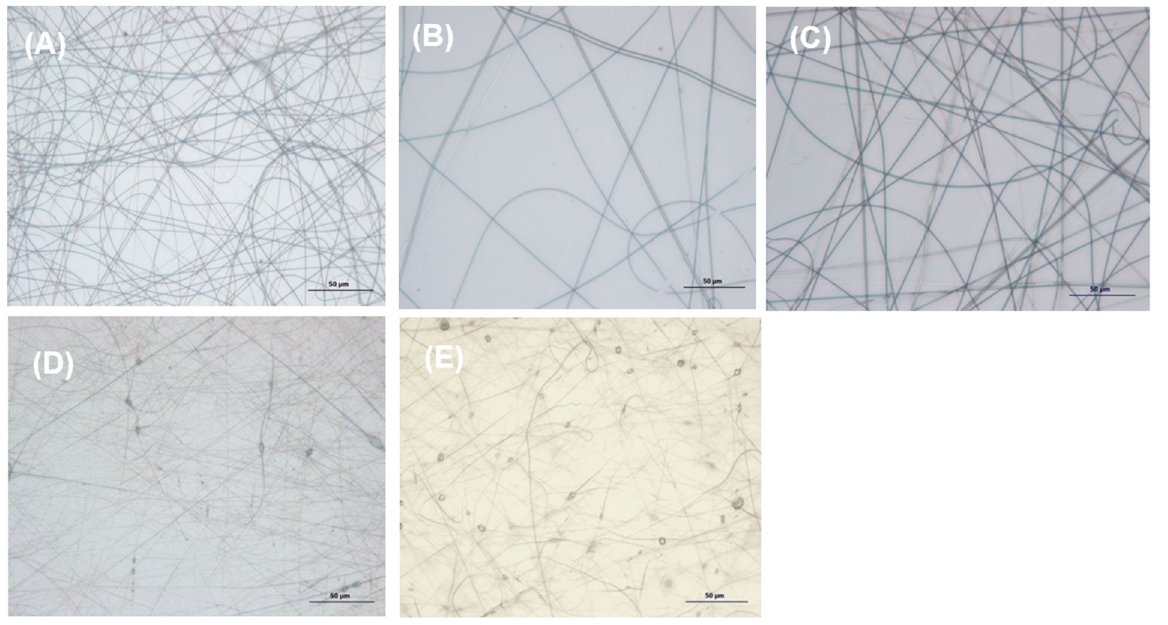
Figure 4. OM images illustrating random fibers of homo- and copolymer meshes using voltages of 18 kV at a distance of 20 cm. ( A ) PAA, ( B ) P(AA- co -SS) 70:30, ( C ) P(AA- co -SS) 50:50, ( D ) P(AA- co -SS) 30:70 and ( E ) PSS. Optical magnifications were 40×.